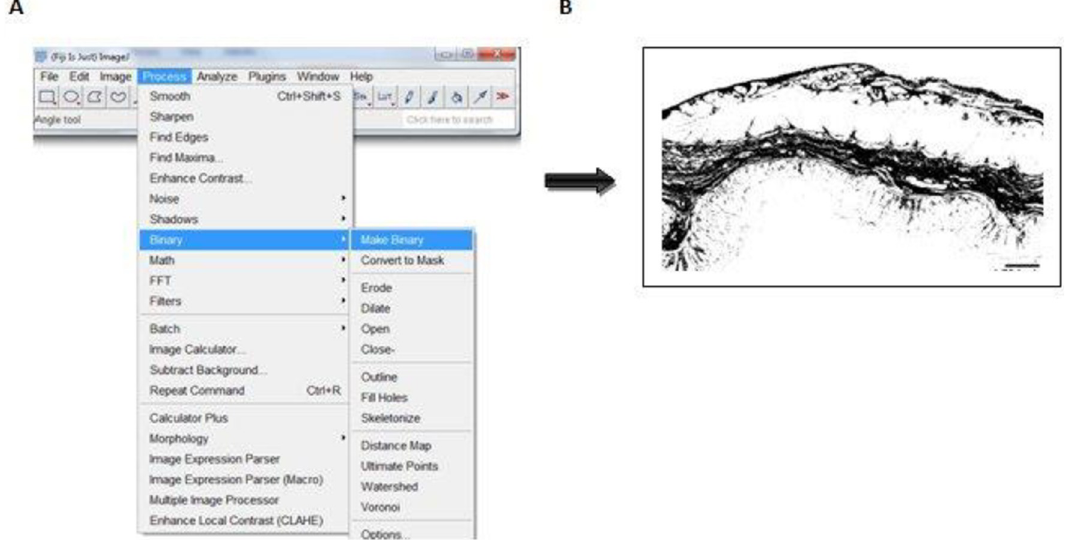
Fig 3. Conversion of threshold image to greyscale for quantification. To convert the threshold image into 8-bit greyscale, (A) “Process” is selected from the menu, and when “Binary” and “Make Binary” is clicked, a greyscale image is achieved ( B ). Scale bar represent 60 μ